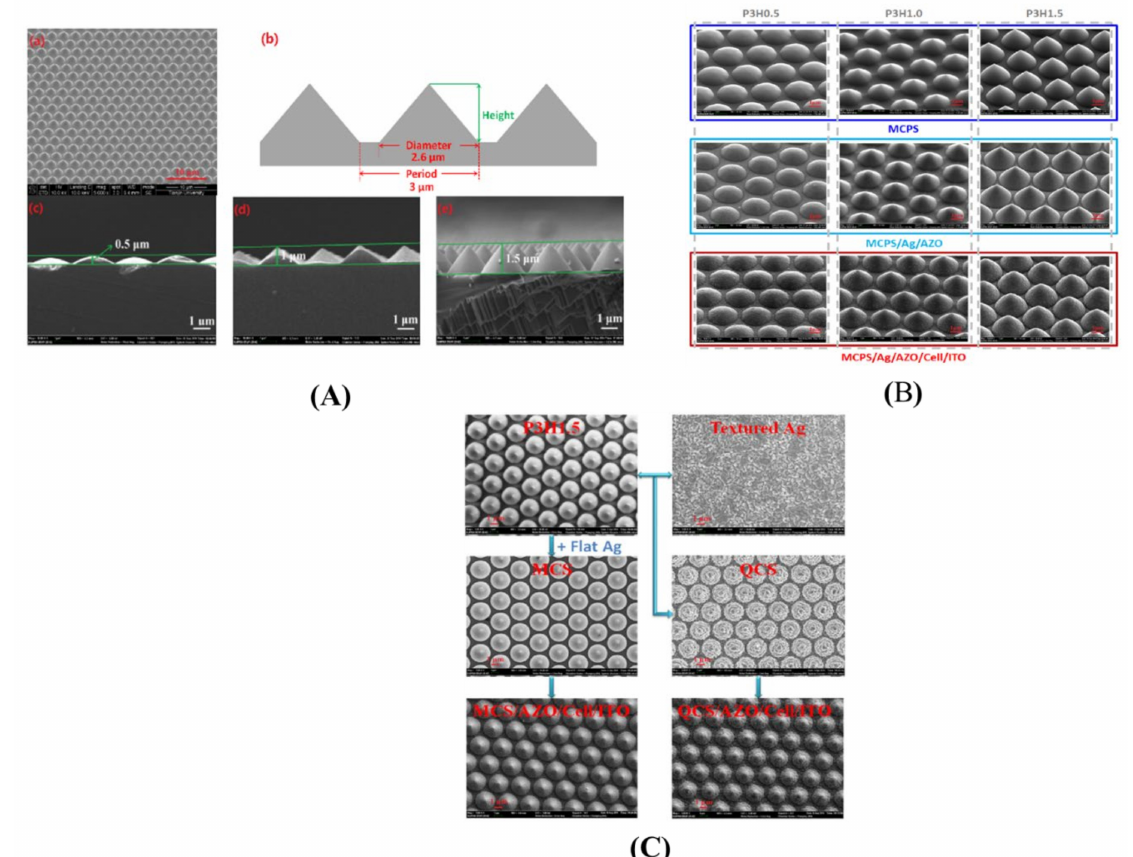
Figure 14. ( A ) ( a ) SEM image of a microcone-patterned substrate (MCPS) with a uniform microcone pattern; ( b ) schematic structure of the microcone pattern; ( c – e ) cross-sectional SEM of MCPSs with different H/P. ( B ) SEM images of MCPS (P3H0.5, P3H1.0, P3H1.5), MCPS coated with Ag/AZO, and a corresponding solar cell. ( C ) SEM images of microcone structure (MCS), quasicrystal structure (QCS), and MCS-based and QCS-based a-SiGe:H solar cells [28] (reprinted with permission from [28], 2017, Creative Commons CC-BY